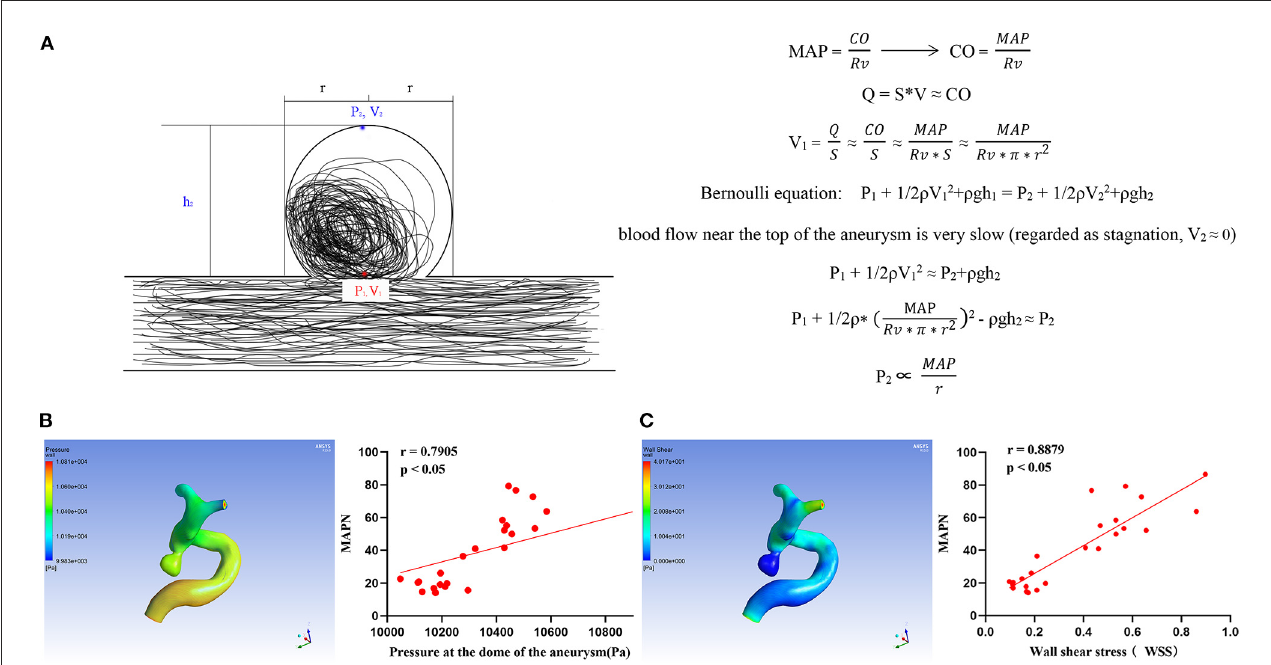
FIGURE2 (A) Formula derivation of the relationship between MAPN and pressure at aneurysm dome MAP, mean arterial pressure; CO, cardiac output; Rv, peripheral resistance; Q, liquid flow; S, pipe diameter area; V, liquid flow rate; P 1 and P 2 are the static pressure, ρ , density; h, vertical height; g, acceleration of gravity. (B, C) Relationship between MAPN and wall shear stress and aneurysm pressure at the dome, respectively.